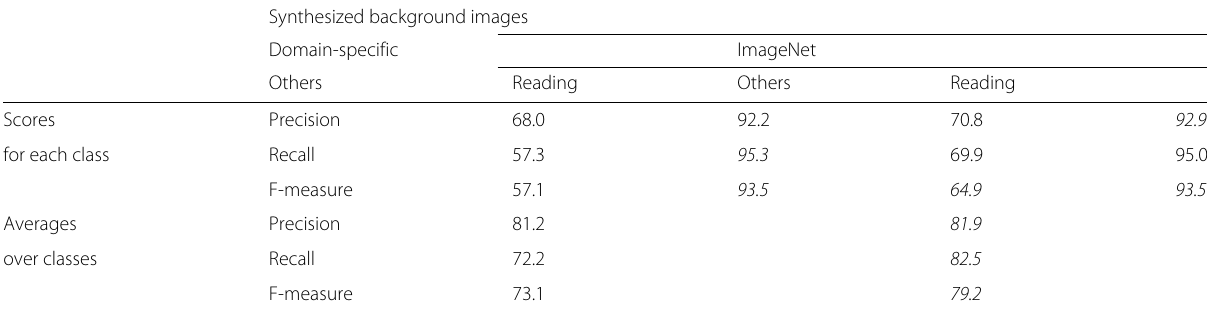
Table 9 Results of the comparison with the dataset synthesized by domain-specific background